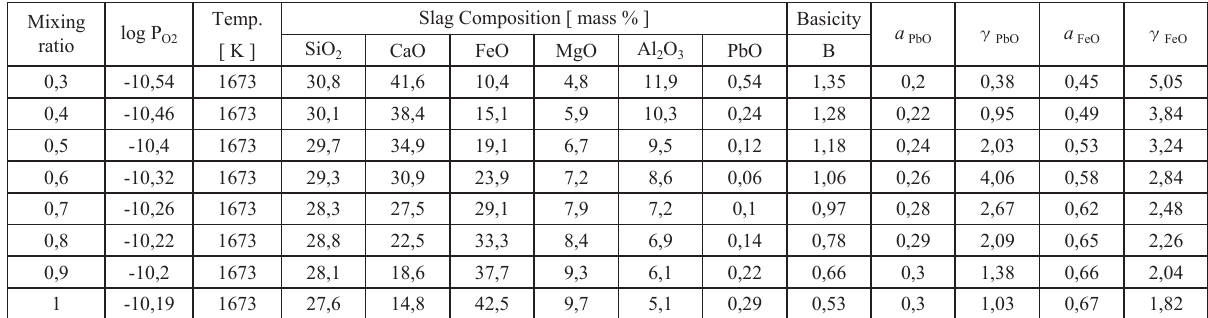
Table 3. PbO content of the stainless steelmaking slag mixed with the nonferrous smelting slag equilibrated with pure liquid Pb.